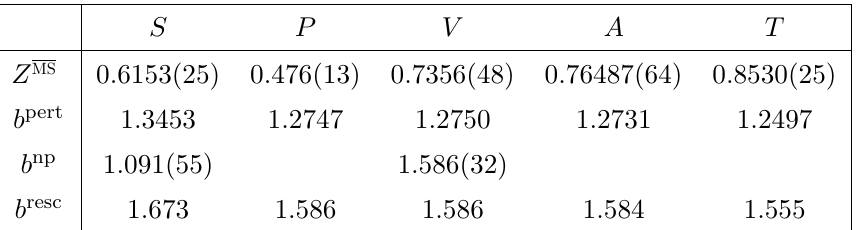
Table 3. Renormalisation factors Z MS